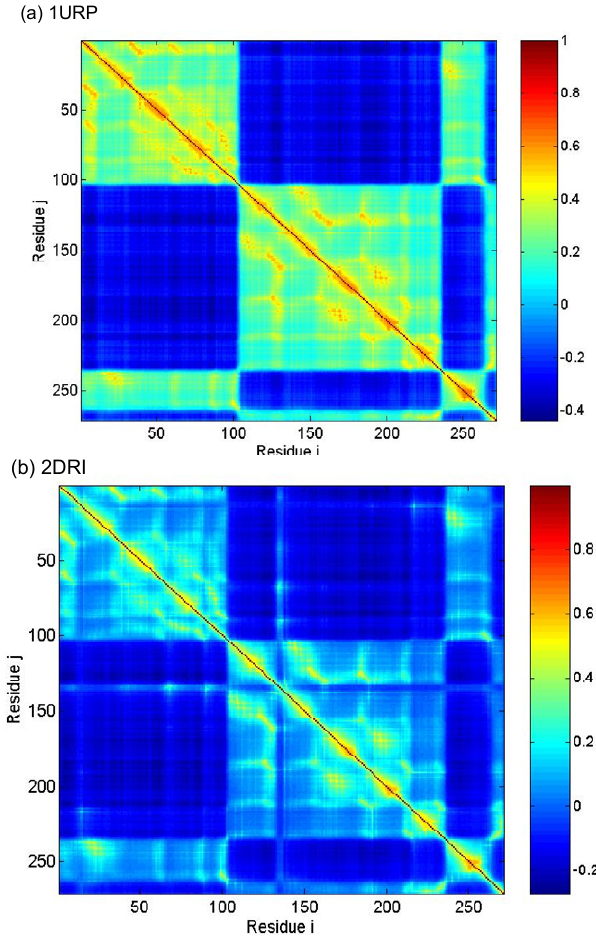
Figure 7. Cross-correlations map between residue fluctuations ( a ) 1URP and ( b ) 2DRI: The two axes refer to residue indices, and the colors indicate different strengths and types of interresidue orientational correlation functions [Equation (6)]. Blue and red regions correspond to negatively (opposite direction) and positively (same direction) correlated motions,